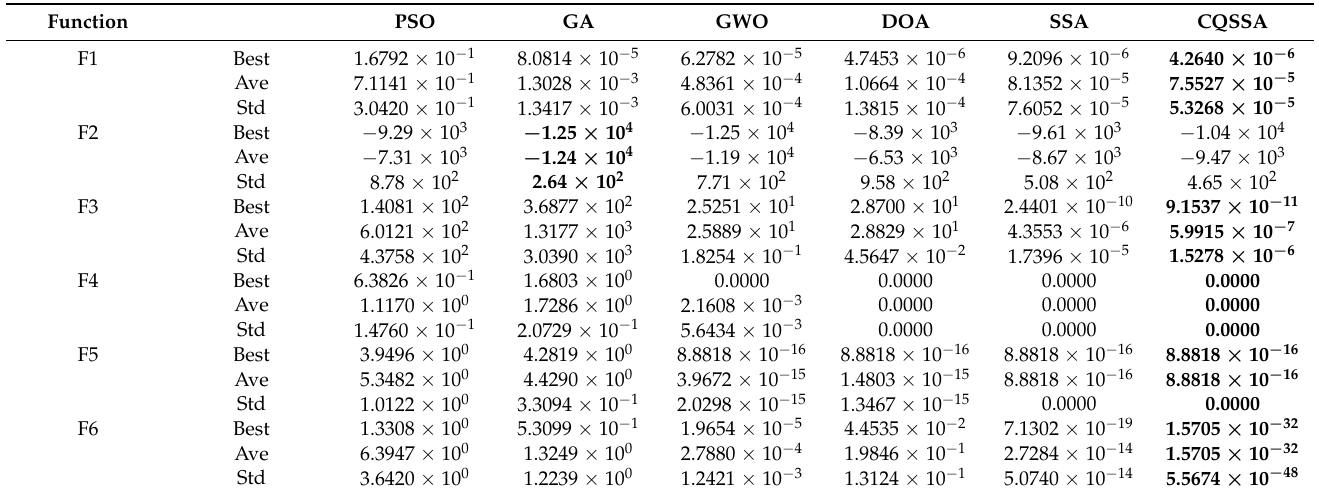
Table 2. The simulation results of the six algorithms on different test